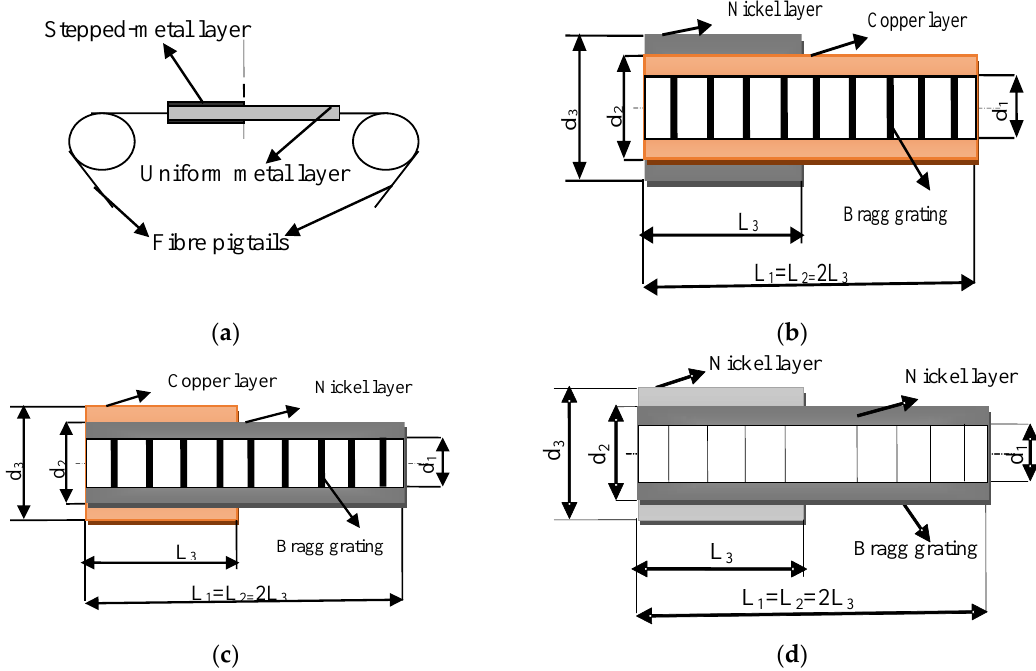
Figure 3. Schematic of the stepped-metal coated-fiber Bragg gratings (SMC-FBGs). ( a ) appearance diagram, ( b ) axisymmetric diagram of Type A SMC-FBG, ( c ) axisymmetric diagram of Type B SMC-FBG, ( d ) axisymmetric diagram of Type C SMC-FBG.